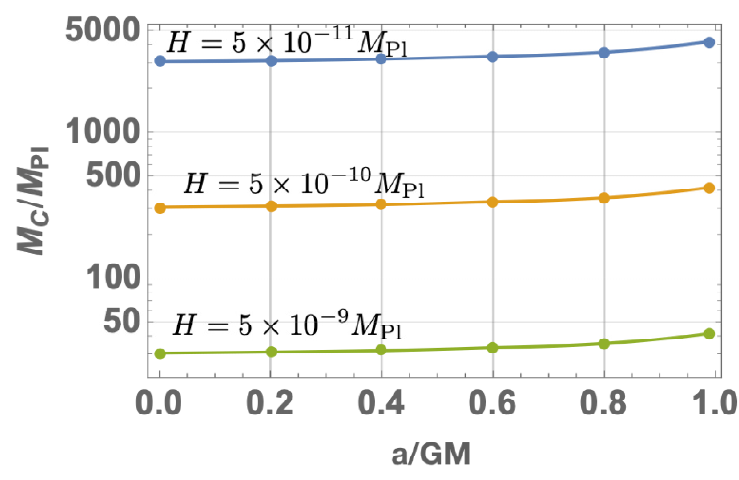
Figure 9 . Plot of the spin-dependence of the critical mass with di(cid:11)erent values of H and (cid:6) =H = 4 (cid:2) 10 (cid:0) 7